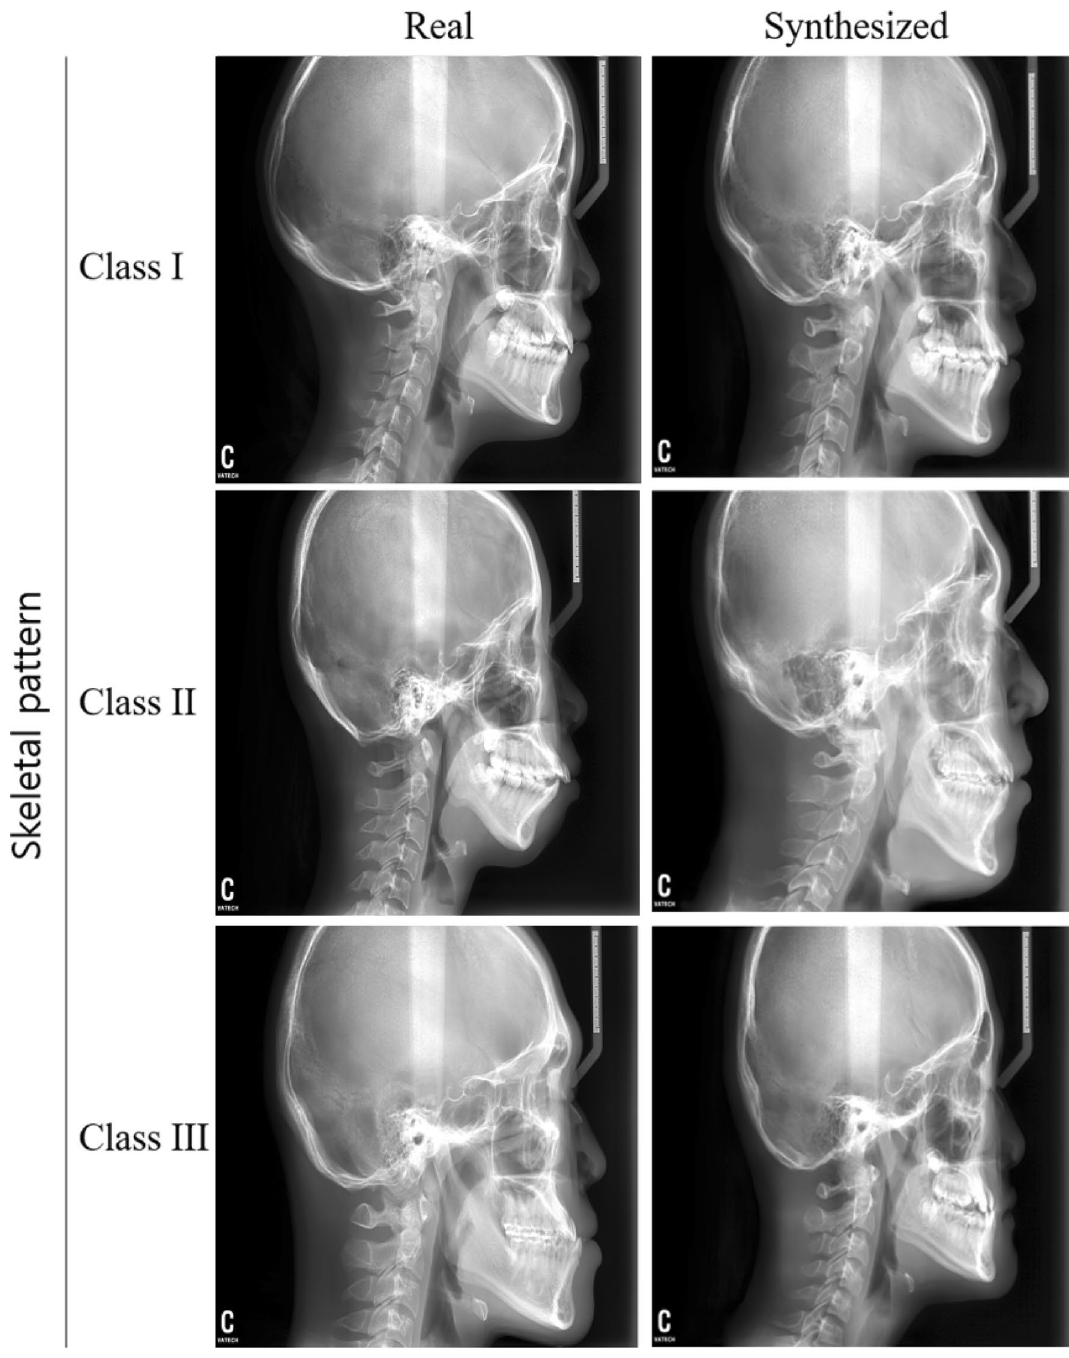
Figure 2. Examples of real and synthesized images for each skeletal